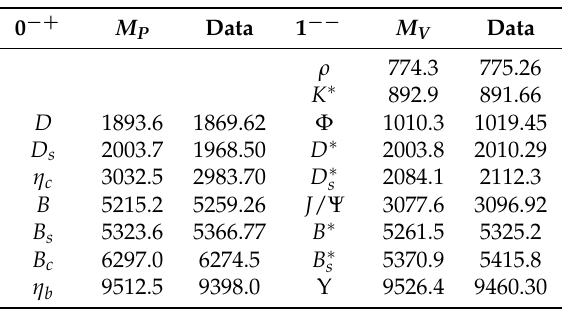
Table 1. Estimated masses of conventional mesons M P and M V (in units of MeV) for model parameters (35) compared to the recent experimental data